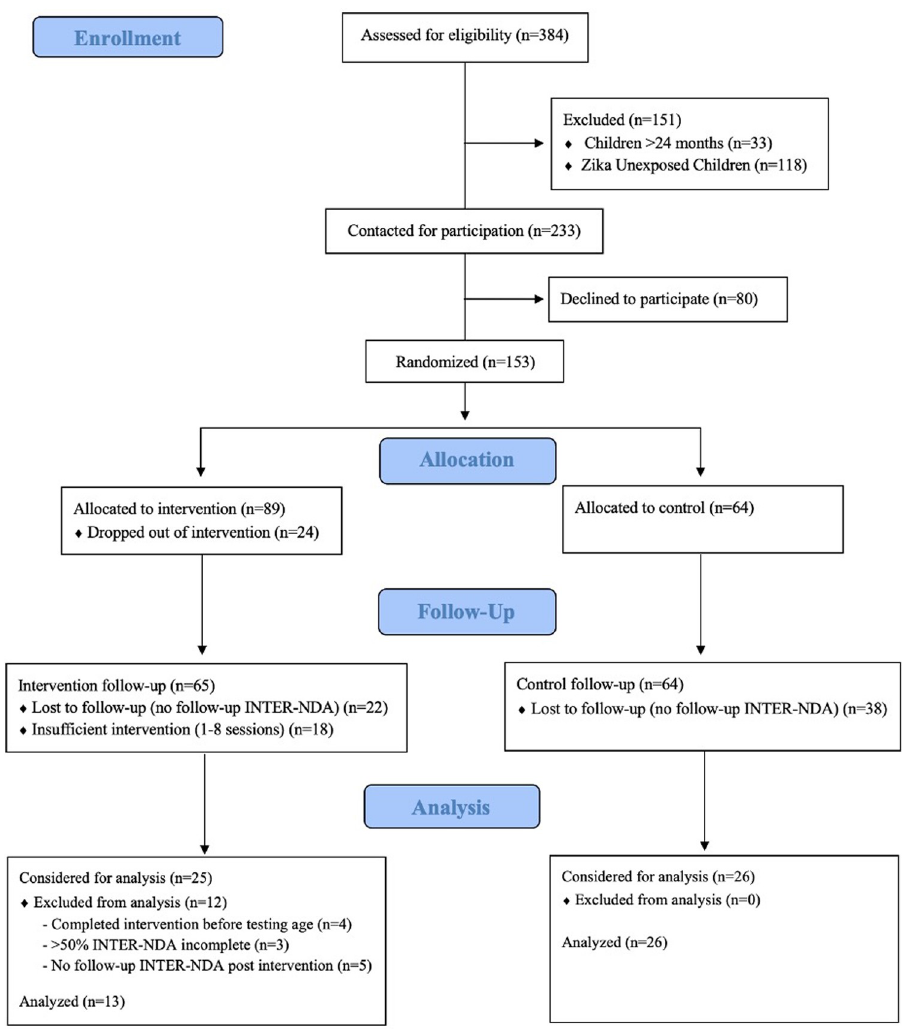
Fig 1. CONSORT Flow